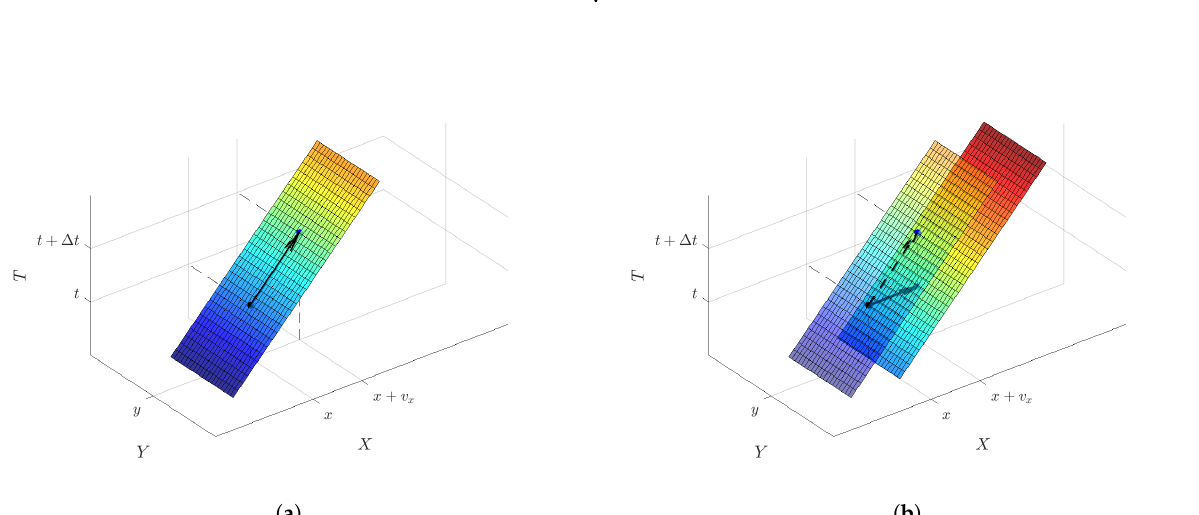
Figure 2. Principle of the time surface matching. ( a ) The time surface formed when a line segment over the Y direction moves in the X direction. The event timestamp is color-coded (with red for the most recent and blue for the oldest part of the time surface). The non-transparent surface in ( b ) is the ∆ t shifted time surface. Time Surface Matching Loss evaluated the consistency of the timestamps between the time surface and the shifted time surface.